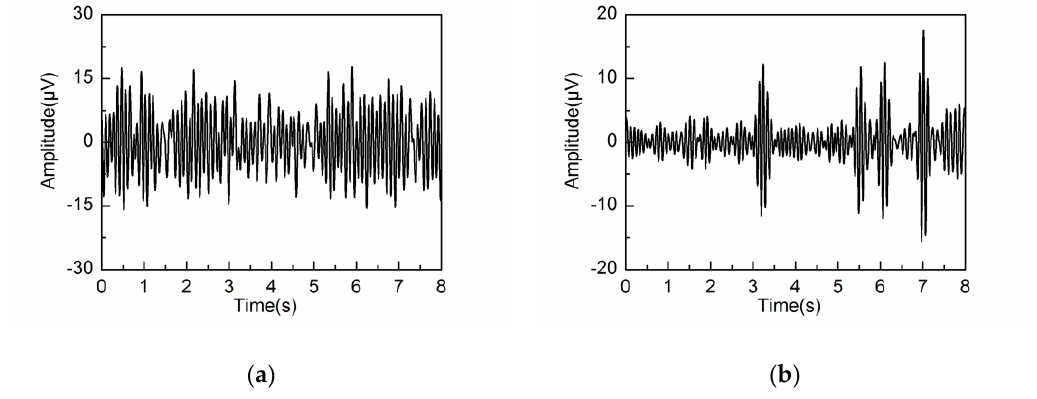
Figure 15. Extracted alpha rhythm by SSA# under: ( a ) eyes-closed condition; ( b ) eyes-open condition.